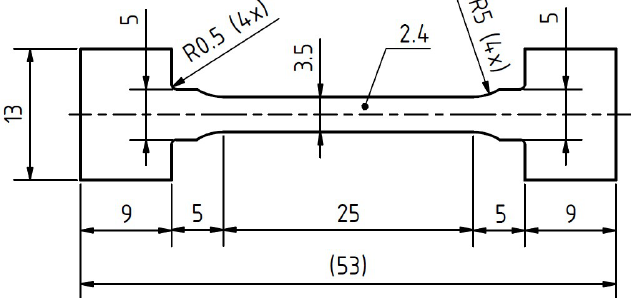
Figure 1. Dimensions and shape of the flat dog-bone specimens for tensile and creep testing.